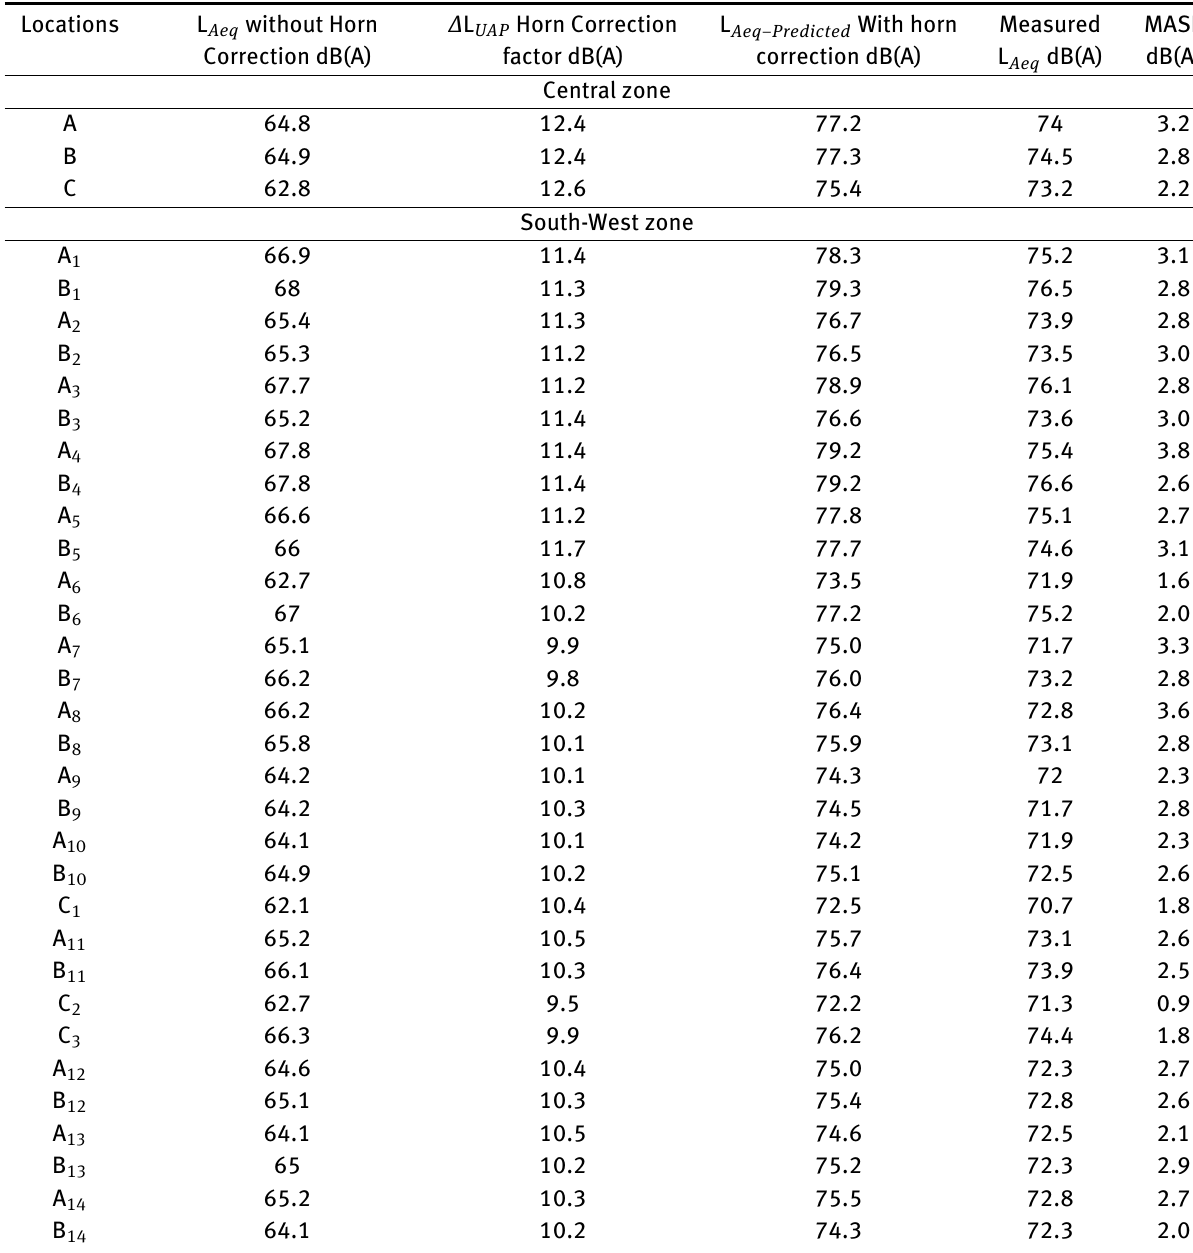
Table 9: Measured L Aeq VS L Aeq − Predicted after modelling